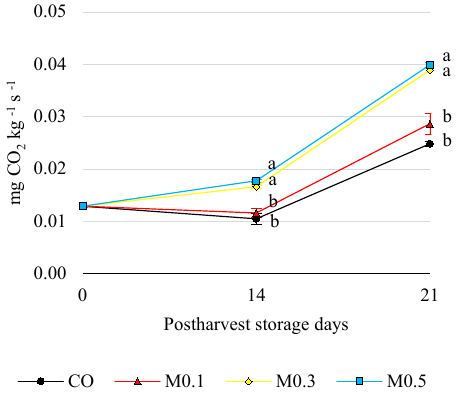
Figure 2. Respiration rate (mg CO 2 kg − 1 s − 1 ) of ‘Samba’ cherries in relation to treatments and storage time. Mean values ± SE (n = 3). By storage time, different letters indicate significant differences among treatments by Tukey’s test ( p ≤ 0.05).